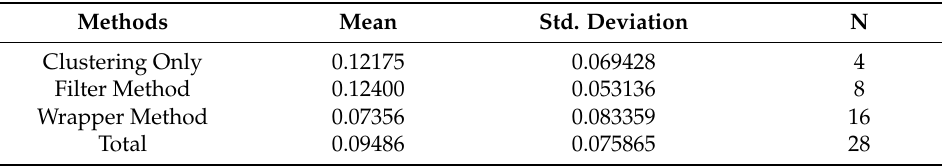
Table 2. Descriptive statistics.